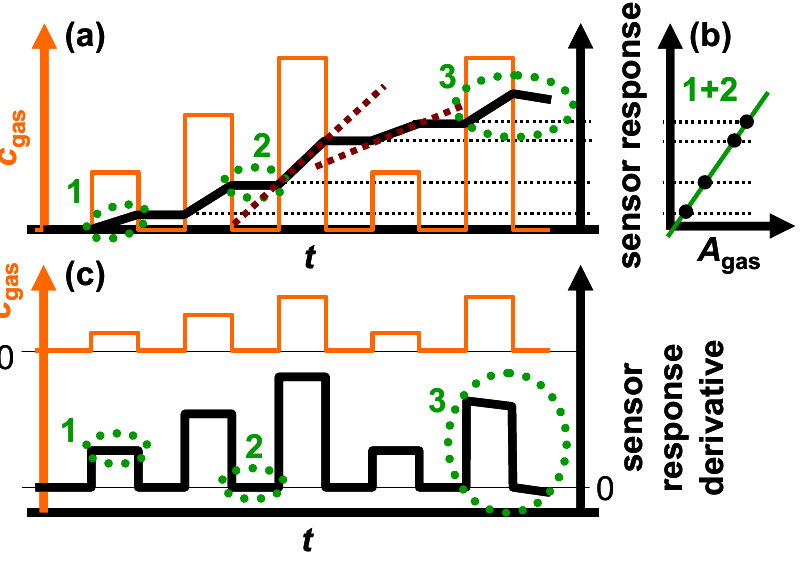
Figure 2. Fundamentals of the sensor response of an ideal accumulating-type gas sensor. ( a ) Increasing sensor signal on the time scale during cyclic gas exposure due to accumulation. ( b ) Resulting characteristic line: correlation with the total amount A ( c ) Curve of the signal derivative: correlation with the actual concentration c